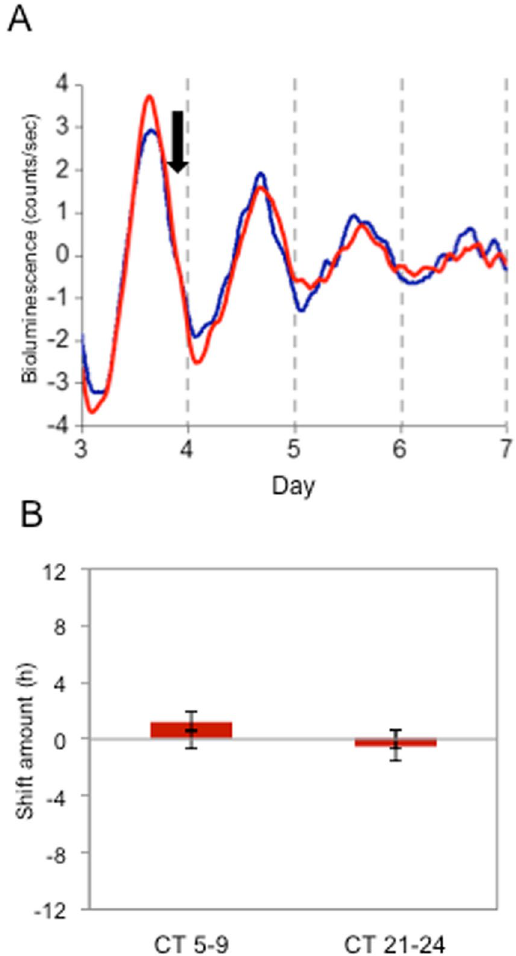
− / − PER2::LUC mice. Representative example shows that DA treatment at CT 24 did not phase-shift 2 R D 2 R − / − PER2::LUC bioluminescence rhythm ( A ). The blue trace indicates a control (Veh treated) and red trace indicates a DA treated RPE-choroid culture. The black arrow indicates time of the drug or vehicle treatment ( A ). DA treated RPE-choroid cultures at CT 5–9 and at CT 21–24 were averaged for statistical analysis. Data were used to calculate the phase change of D 2 R − / − versus controls. Bars show the mean amount of phase change from controls and error bars show ± SEM for experimental groups. Error bars from x axis show ± SEM for control groups. No phase-shifts were observed in the D 2 R − / − PER2::LUC RPE-choroid rhythms at either time points ( B ) t -test, n = 6 for DA and Veh for each time